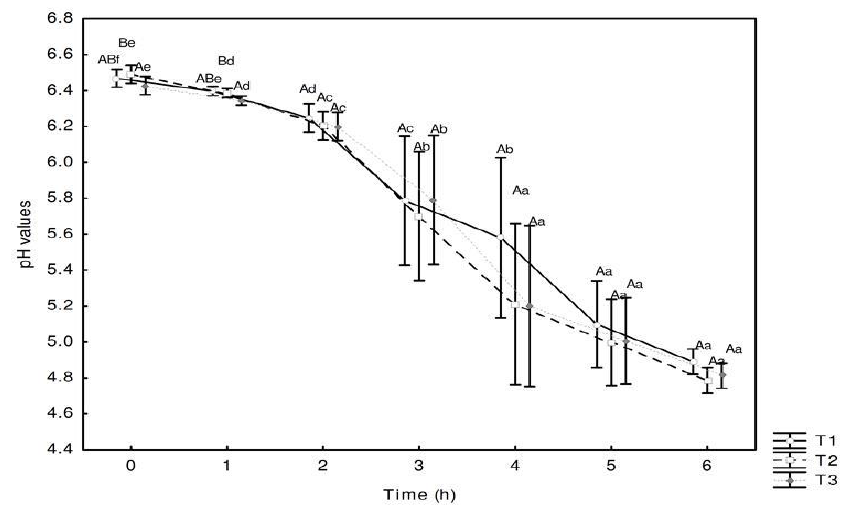
Figure 1. Changes in the mean values of pH of dairy bases during the fermentation of T1 (control, without lactobacilli adjunct), T2 (commercial probiotic, with L. rhamnosus LR32) and T3 (experimental probiotic, with the indigenous culture L. plantarum CNPC003) trials. Different uppercase letters denote significant differences between trials for the same fermentation time ( p < 0.05). Different lowercase letters denote significant differences between fermentation times for the same trial ( p < 0.05).